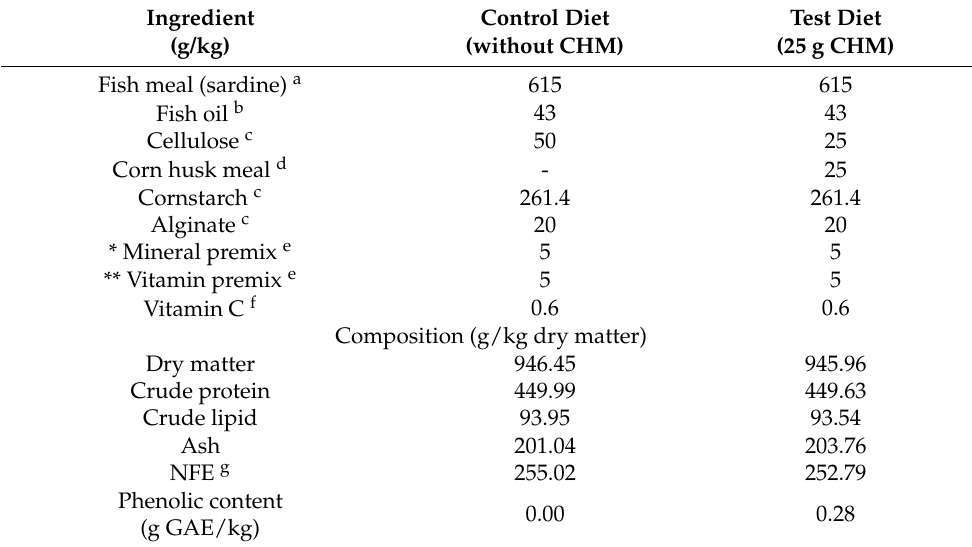
Table 3. Ingredients, proximate composition, and PC content of the experimental diets for Nile tilapia. Ingredient